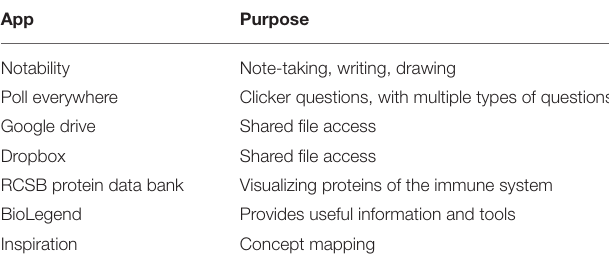
TABLE 6 | iPad apps useful in immunology